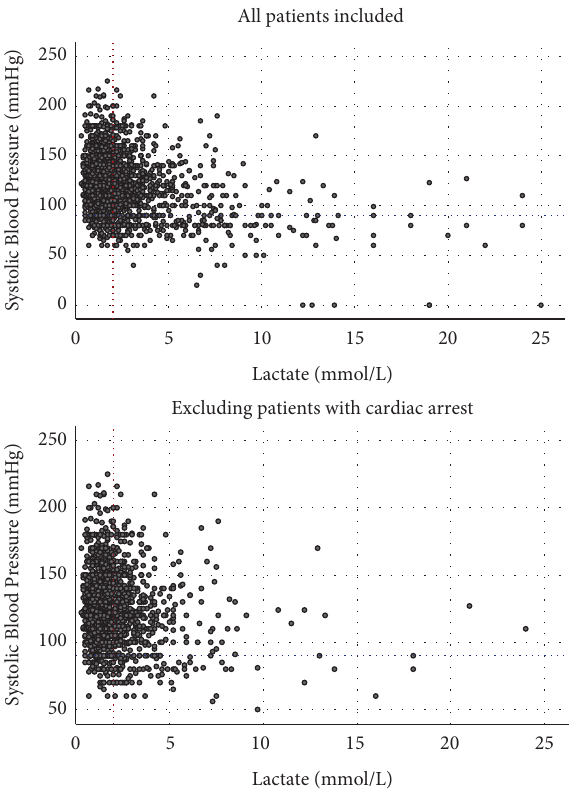
96 (10.8) Figure 1: Scatter plots of lactate and systolic blood pressure (SBP) of patients presenting with acute coronary syndromes. In the top panel, all patients are included, whereas in the bottom one, patients with previous or ongoing cardiac arrest are excluded. The red dotted line indicates lactate cutoff of 2mmol/L, whereas the blue dotted line indicates the traditional 90mmHg